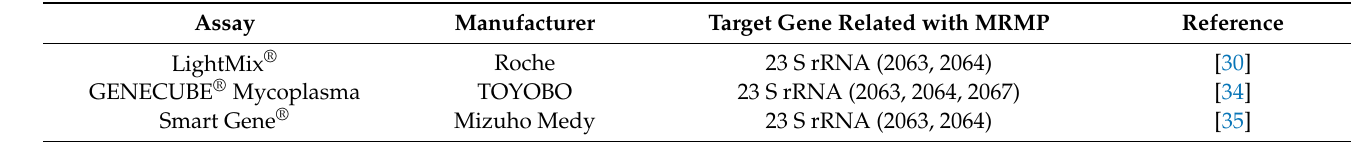
Table 3. The features of commercial kits to detect